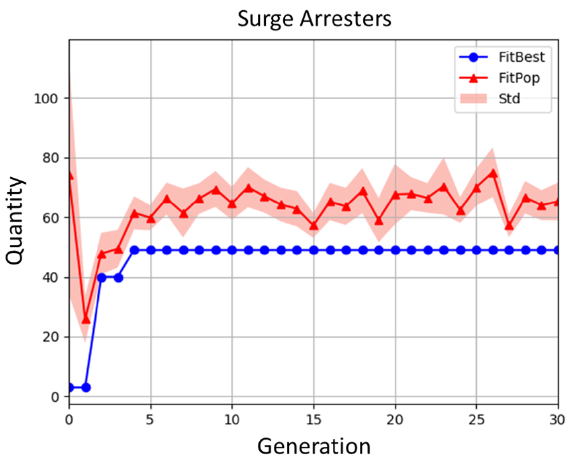
Figure 14. Allocated surge arresters.